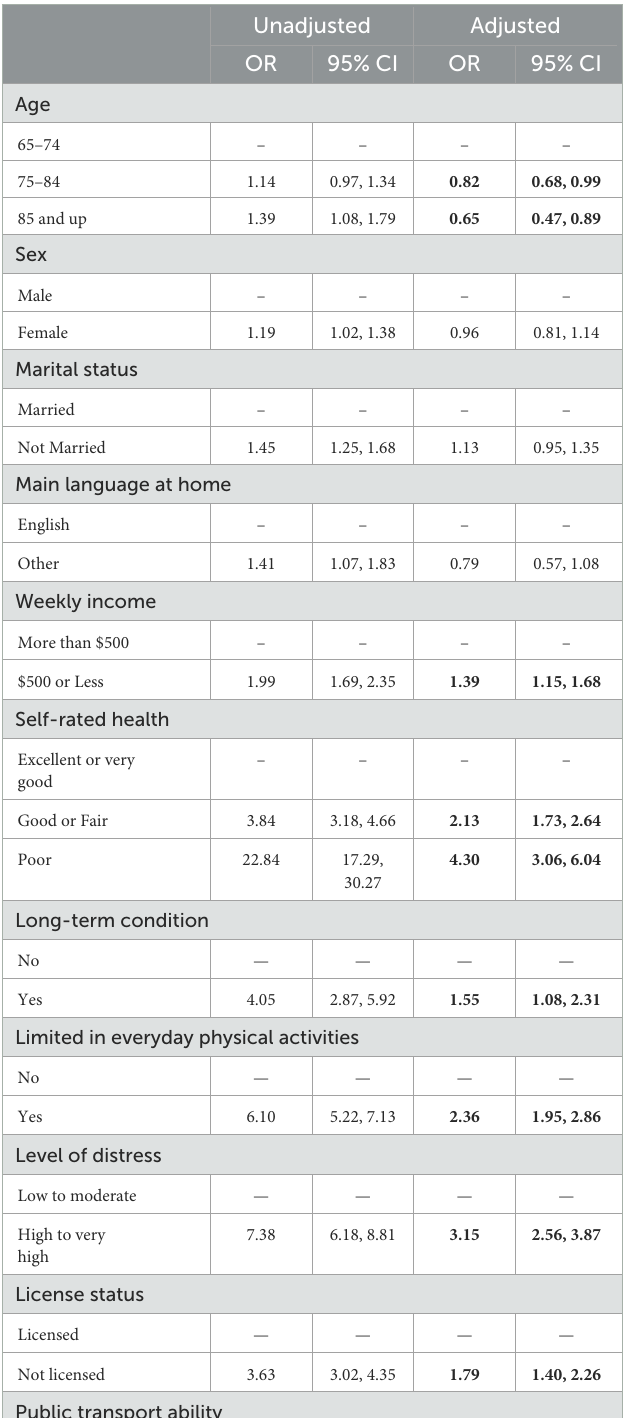
TABLE 2 Sample characteristics. TABLE 3 Regression analysis of unmet mobility